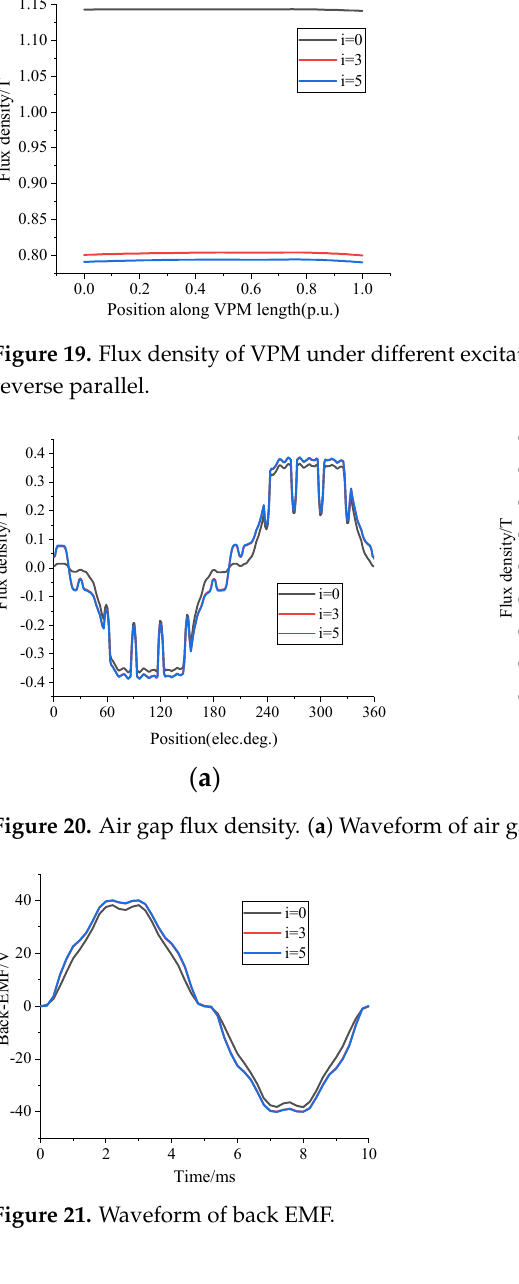
( b ) Figure 22. Motor output torque. ( a ) Output torque with the forward parallel permanent magnet; ( b ) Output torque with the reverse parallel permanent magnet. 6. Conclusions and Shortcomings